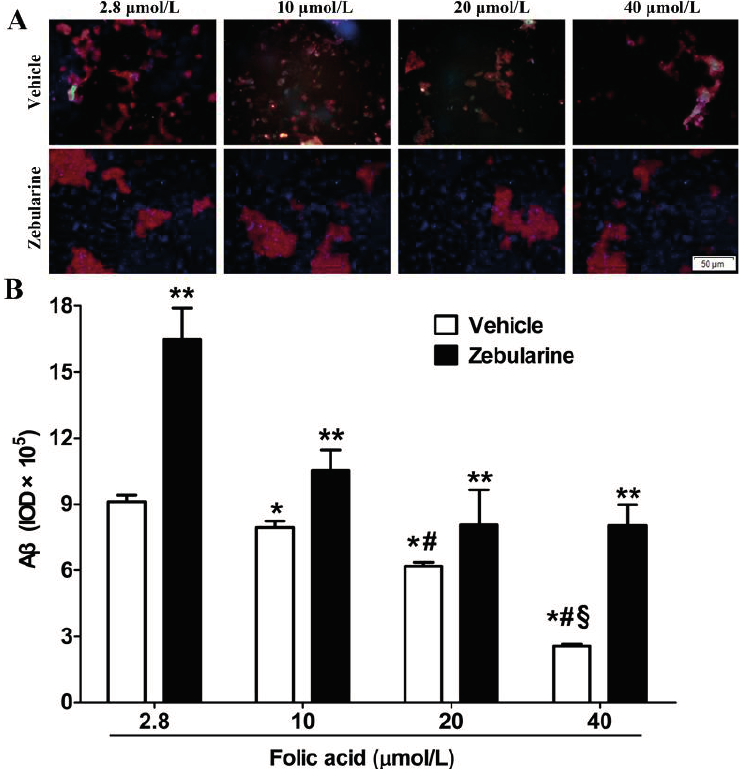
Figure 2. Folic acid decreases, and zebularine increases, A β production in N2a-APP cells. The cells were incubated with 2.8, 10, 20 or 40 μ mol/L folic acid for 96 h, and with either zebularine or its vehicle present during the first 12 h. Subsequently A β was detected by immunofluorescence staining (red), nucleus staining by DAPI (blue). ( A ) Representative images showing A β immunofluorescence; ( B ) Summary of A β production levels shows mean ± SEM for integrated optical density (IOD) of immunoreactive A β in 3 experiments. * p < 0.05 compared with 2.8 μ mol/L. # p < 0.05 compared with 10 μ mol/L. § p < 0.05 compared with 20 μ mol/L. ** p < 0.05 compared with vehicle at the same folate concentration. Scale bar = 50 μ